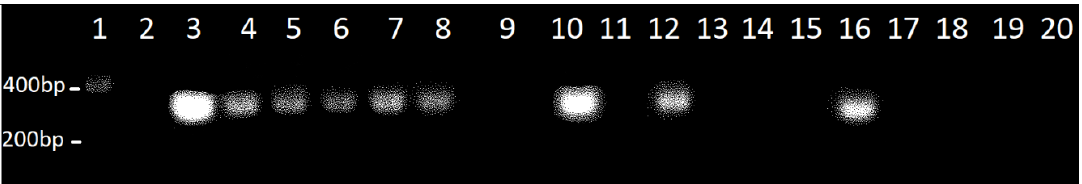
Figure 4. Open reading frame (ORF) A104R was successfully integrated in transfected Vero and COS-1 cells. ORF A104R was amplified by PCR (287 bp) from the genome of Vero-pA104R clones, cultured under antibiotic selective pressure (G418). Line 1: Molecular marker (NZYDNA Ladder III); Line 2: Vero wild type (wt, negative control); Line 3: pIRESneo A104R (positive control); Lines 4–6: three distinct Vero-pA104R clones, transfected with linearized plasmid and Lipofectamine 2000;